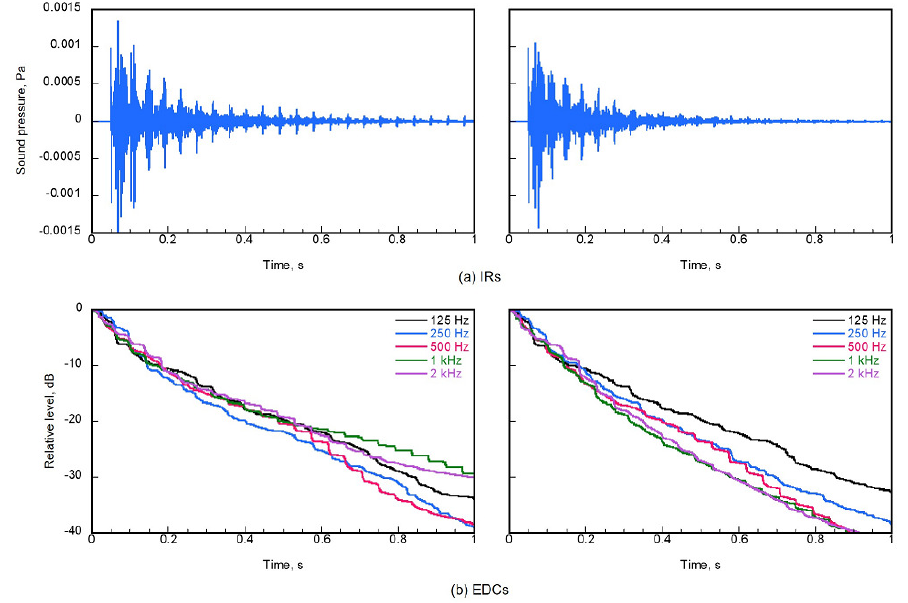
Figure 13. Calculated results at receiver R13 in Cond. 1 ( Left ) and Cond. 2 ( Right ): ( a ) IRs and ( b )